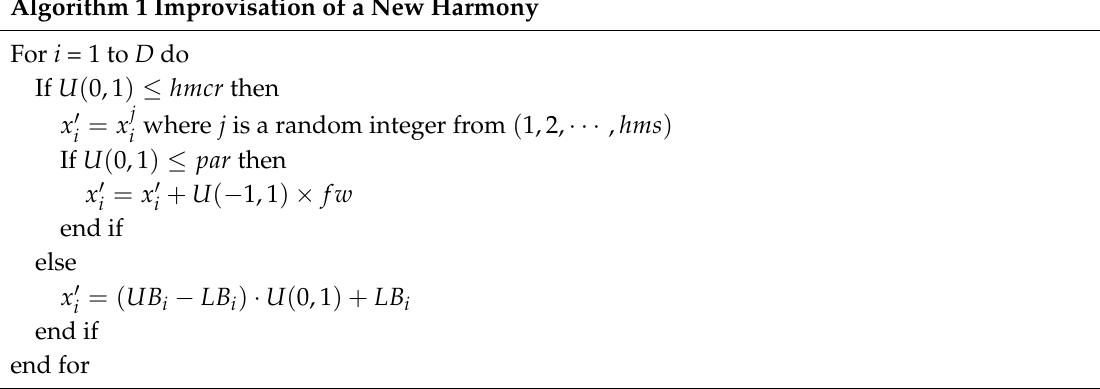
Algorithm 1 Improvisation of a New